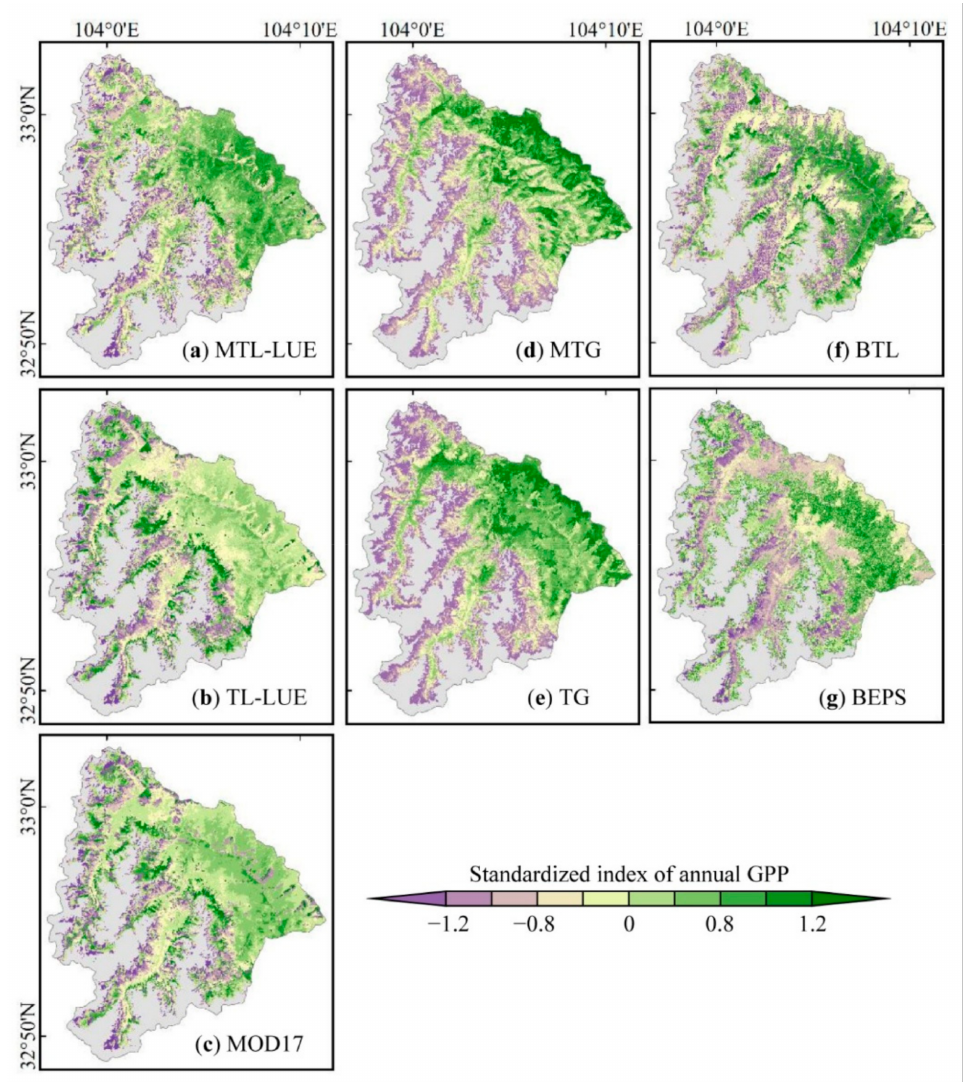
Figure 9. Spatial distributions of the standardized index of annual GPP MTL-LUE ( a ), GPP TL-LUE ( b ), GPP MOD17 ( c ), GPP MTG ( d ), GPP TG ( e ), GPP BTL ( f ), and GPP BEPS ( g ) over Wanglang Reserve. The description of the standardized index can be found in Supplementary Equation